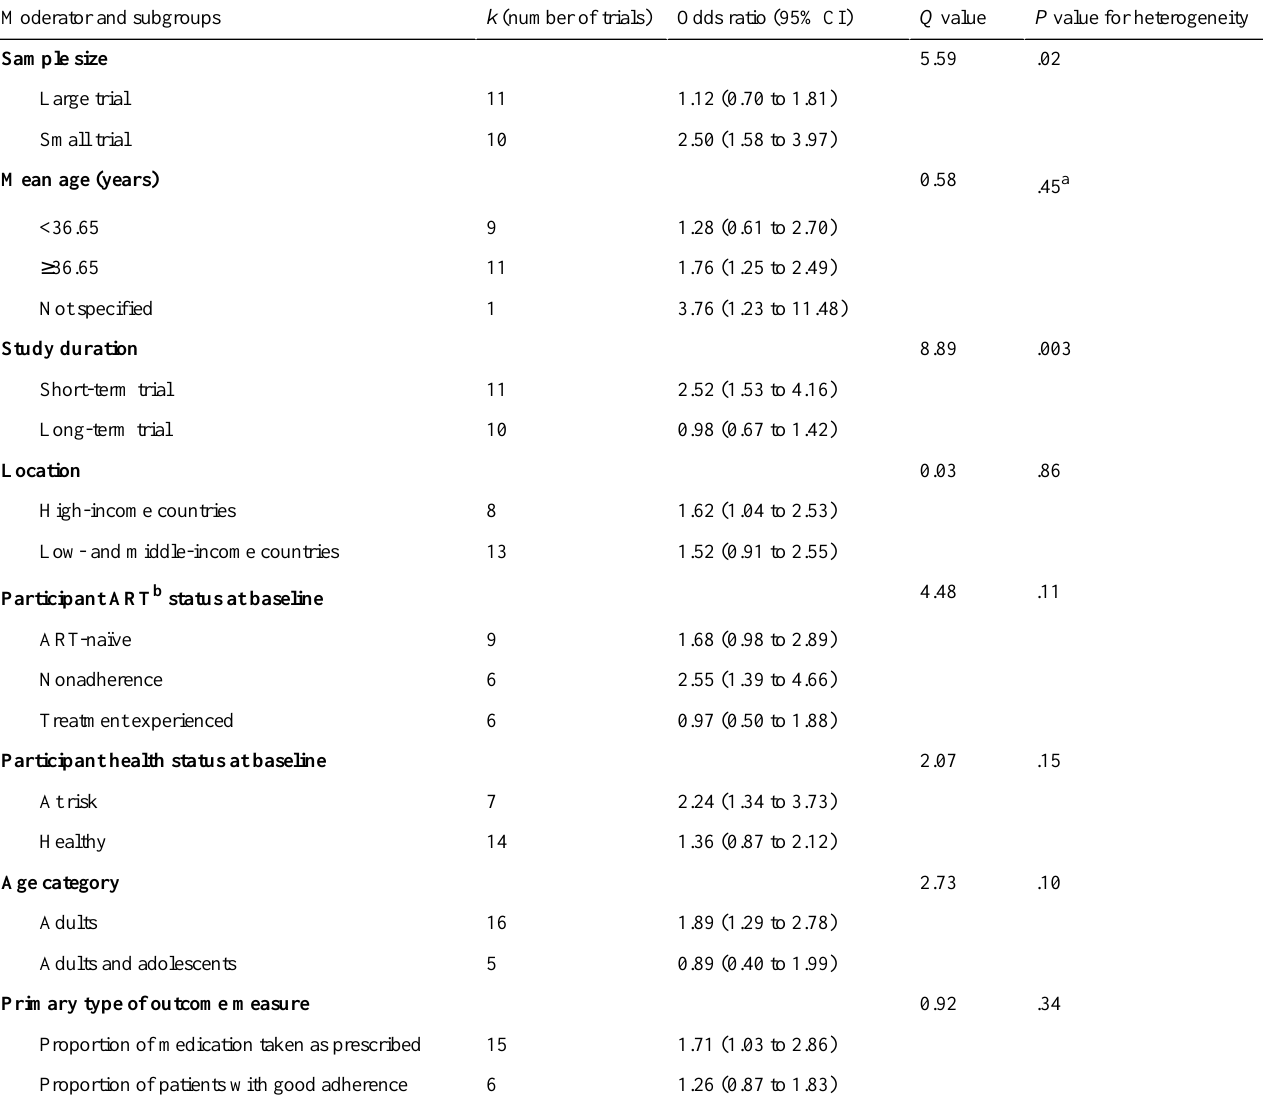
Table 2. Subgroup analyses of the effect of electronic health on antiretroviral therapy adherence by study and participant